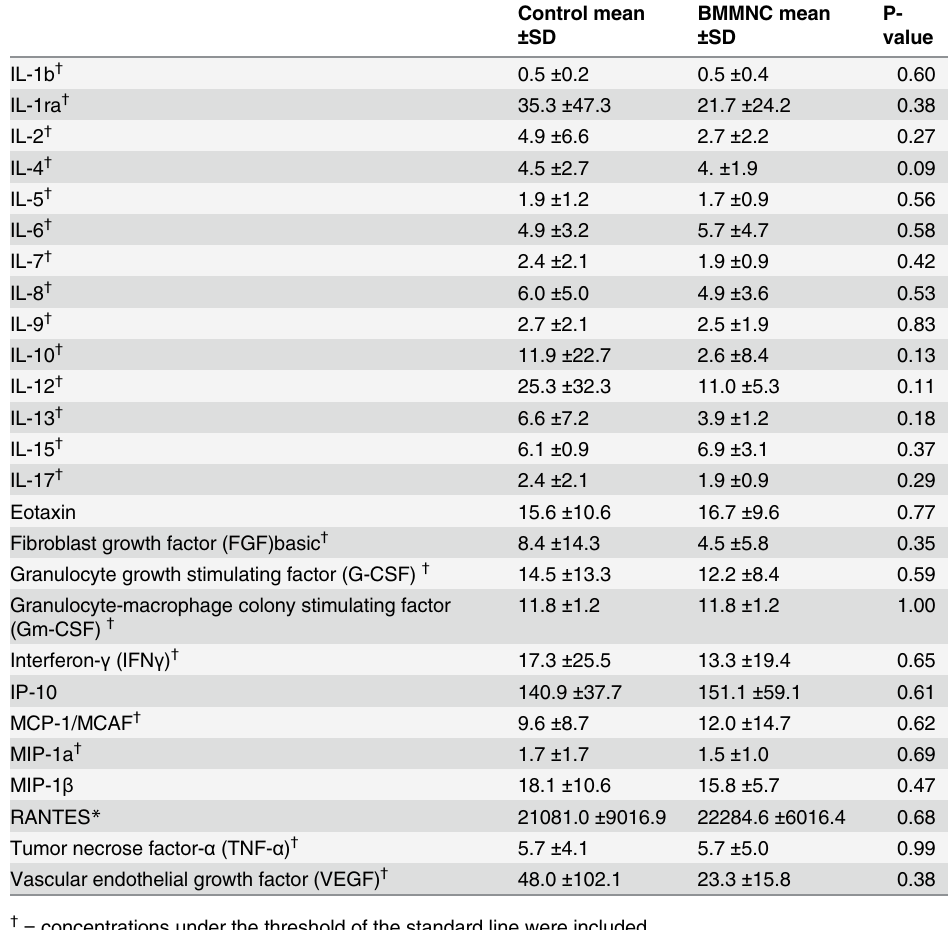
Table 3. Cytokine Concentrations at